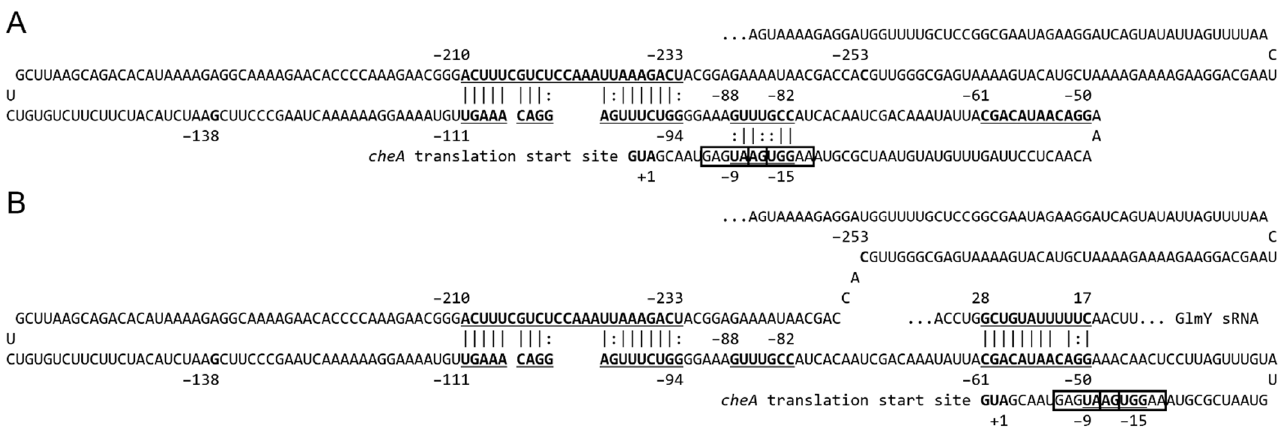
Figure 7. A model for regulation of cheA by GlmY sRNA. ( A ) The model structure for the 5 ′ UTR of cheA mRNA in the absence of GlmY. The expression of cheA is silenced at the post-transcriptional level by pairing − 111 to − 94 with − 233 to − 210 from AUG of cheA 5 ′ UTR and − 88 to − 82 from AUG with the putative ribosome binding site of cheA . ( B ) The putative structure for the 5 ′ UTR of cheA mRNA in the presence of GlmY. GlmY pairs with − 61 to − 50 from AUG of cheA 5 ′ UTR freeing the ribosome binding site and causing the cheA mRNA to be translated. Two overlapped putative ribosome binding sequences (AAGGUGA and GAAUGAG) are indicated in boxes, and the RNA-RNA base-pairing sequences predicted by intaRNA are underlined.